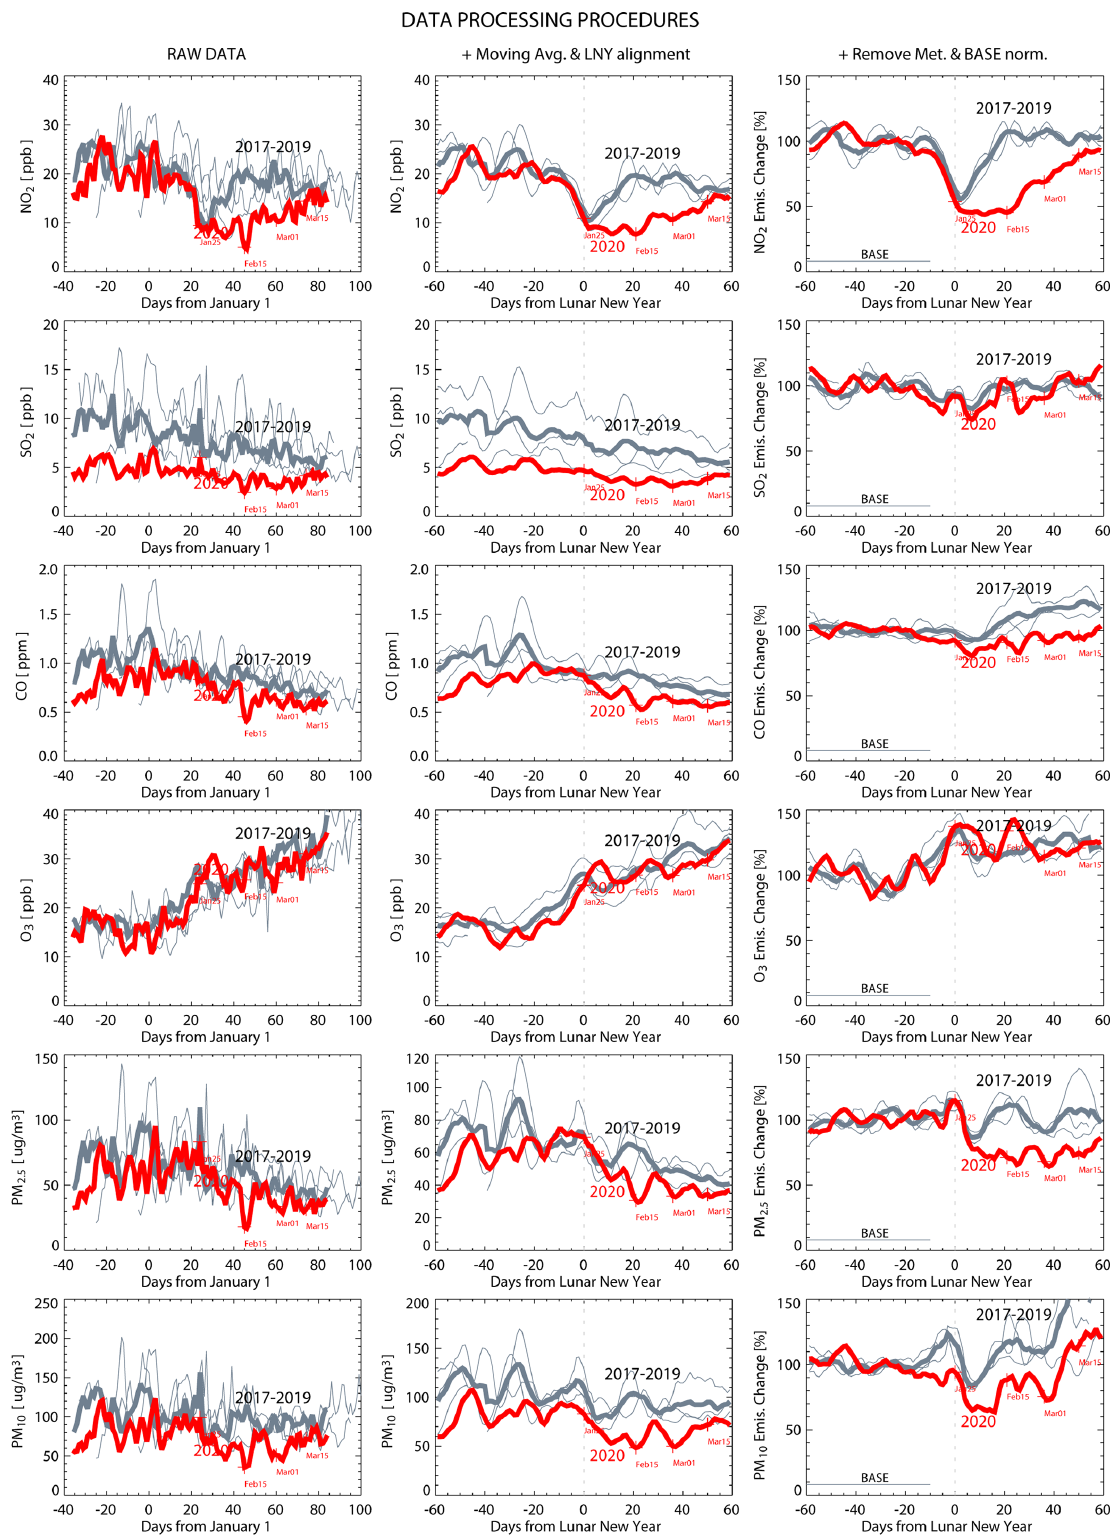
Figure 7. Time series of surface NO 2 , SO 2 , CO, O 3 , PM 2 . 5 , and PM 10 concentrations over China following the data-processing procedures step by step. Raw data (left column), data after applying a 7d moving average and an LNY alignment (middle column), and data after removing meteorological variations and calculating variations from the baseline periods (right column) are all